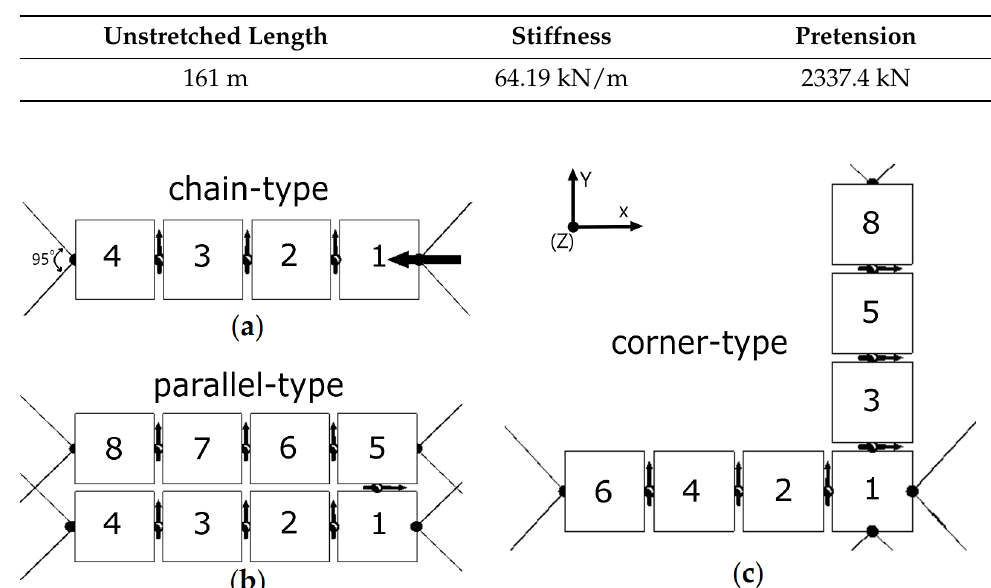
Figure 3. Schematic representation of the considered floating configurations: ( a ) the chain configura- tions; ( b ) the parallel configuration; ( c ) and the corner